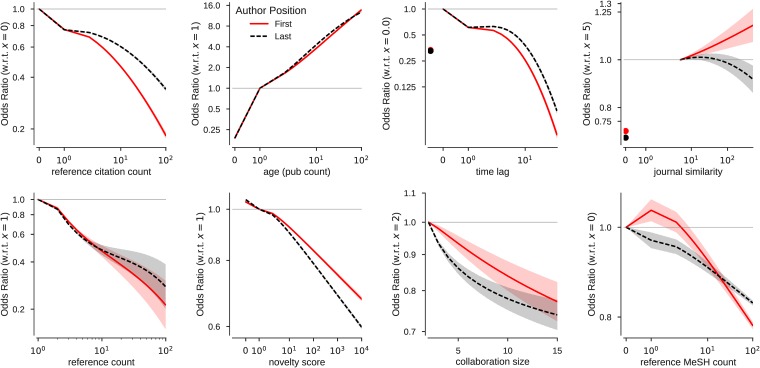
Change in odds with respect to mentioned values (in parentheses) of self-citation for select predictors of models of first and last authors.Shaded regions indicate 95% confidence intervals. Y-axis is on log scale.